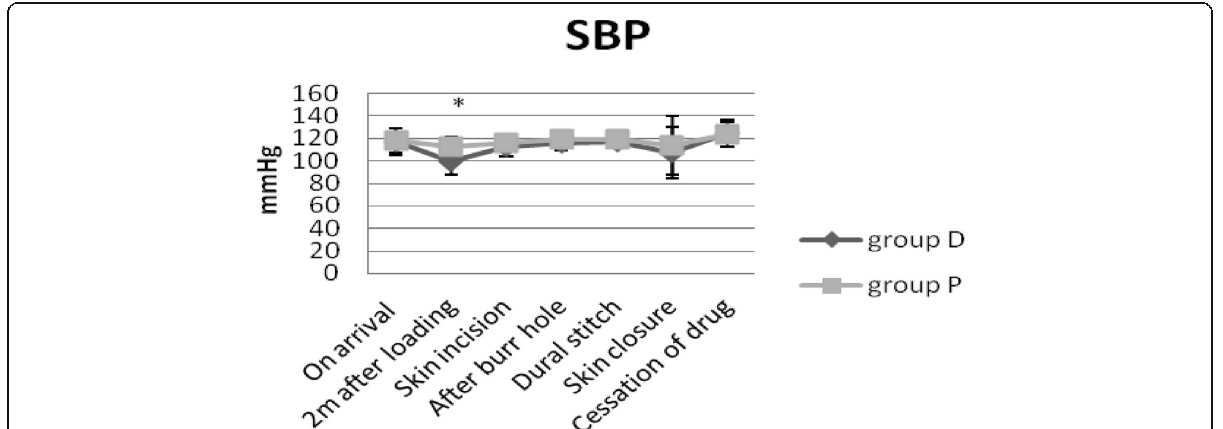
Fig. 2 Changes in SBP. Changes in mean values of SBP over time. Lines are mean SBP and error bars are SD. *Statistical significance between